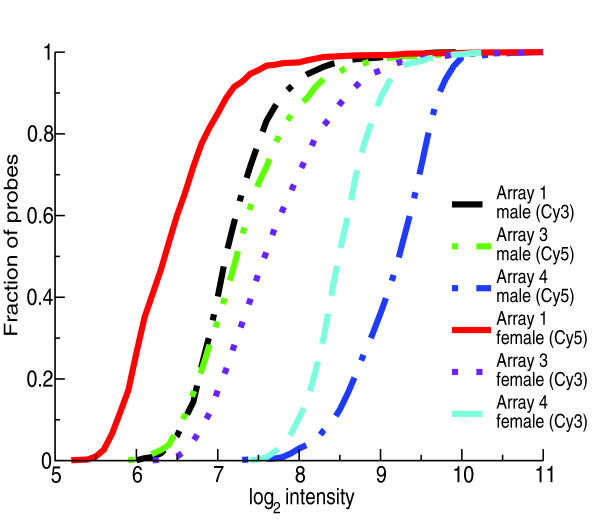
Variation between channels in the distribution of signal intensities for NCPs. Cumulative distribution functions of signal intensities for NCPs for different channels are shown.